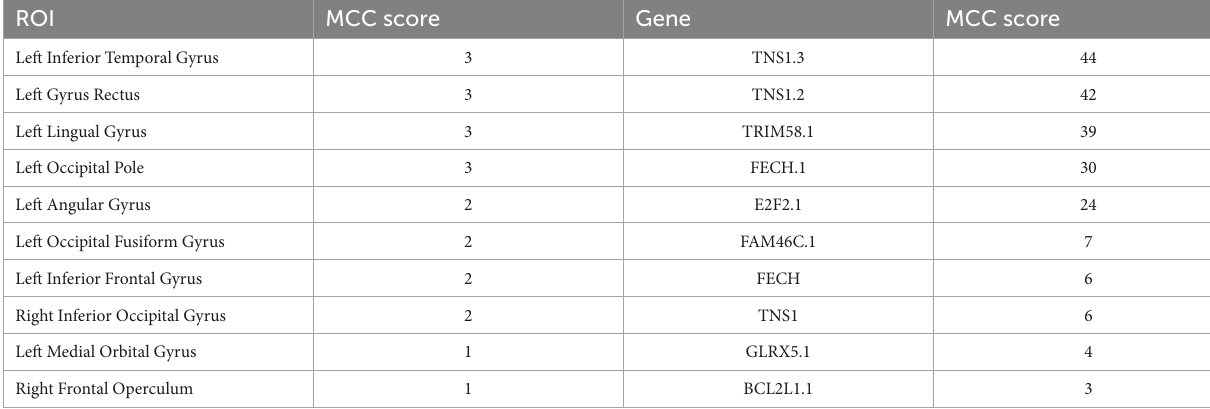
TABLE 5 Top 10 ROIs and genes and their MCC score information in AD group. ROI